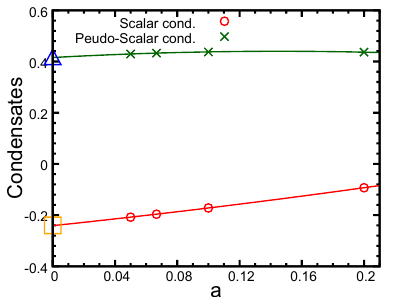
Figure 6 . The continuum extrapolation of the scalar ( ◦ , red) and pseudo-scalar ( × , green) for θ = 2 π using the quadratic function of the lattice constant a . The square and triangle symbols at a = 0 denotes the analytic formula S = e γ qg